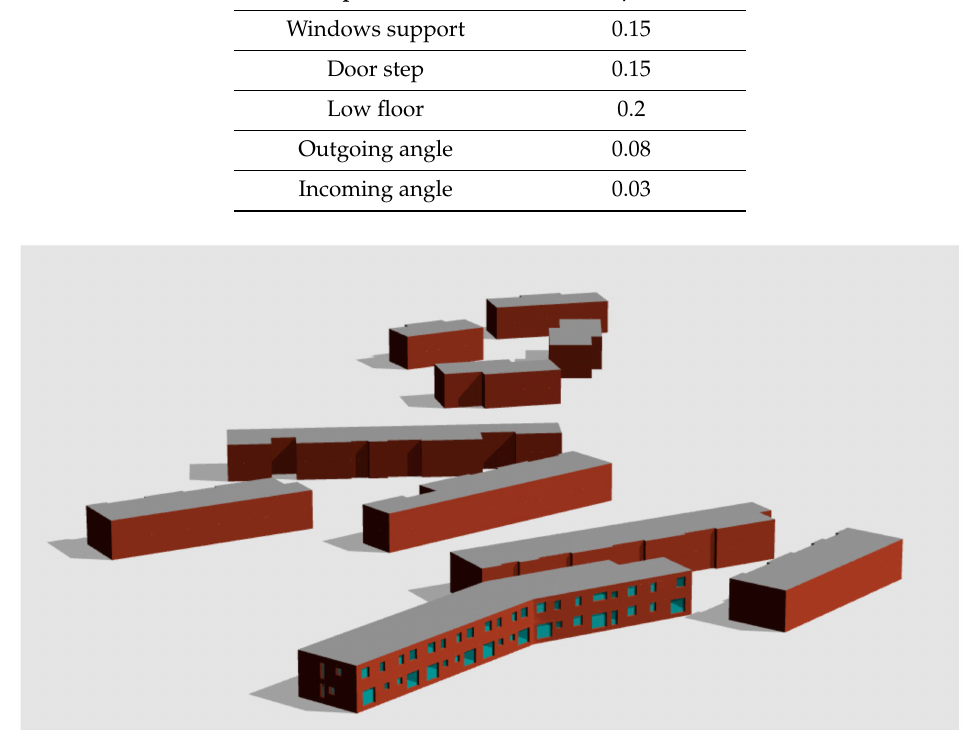
Figure 4. View of the 3D model of the neighborhood as presented in the Pleiades